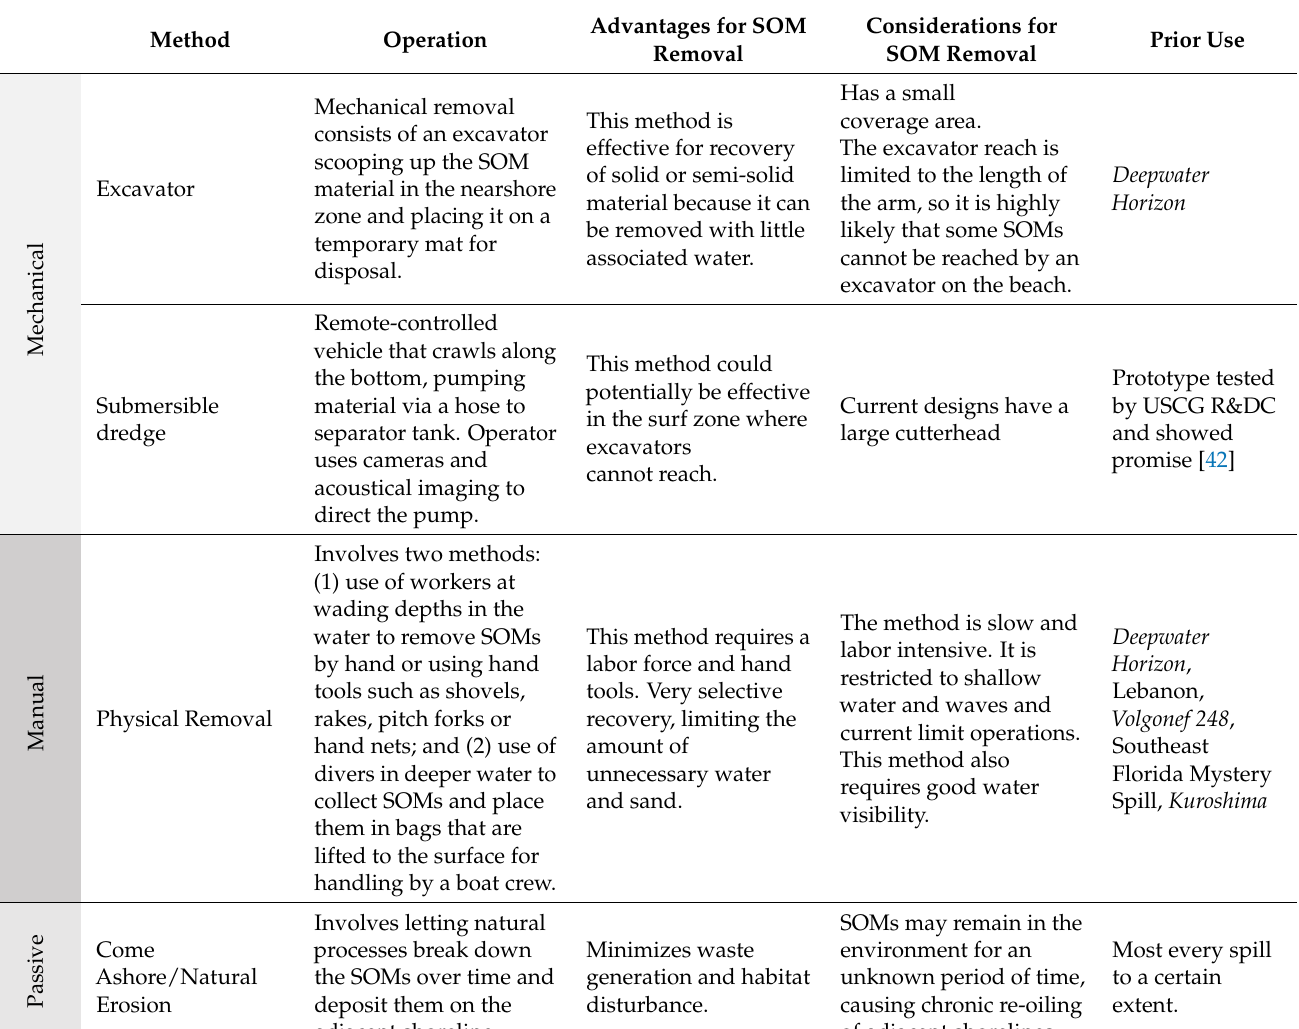
Table 7. SOM recovery methods in surf zone